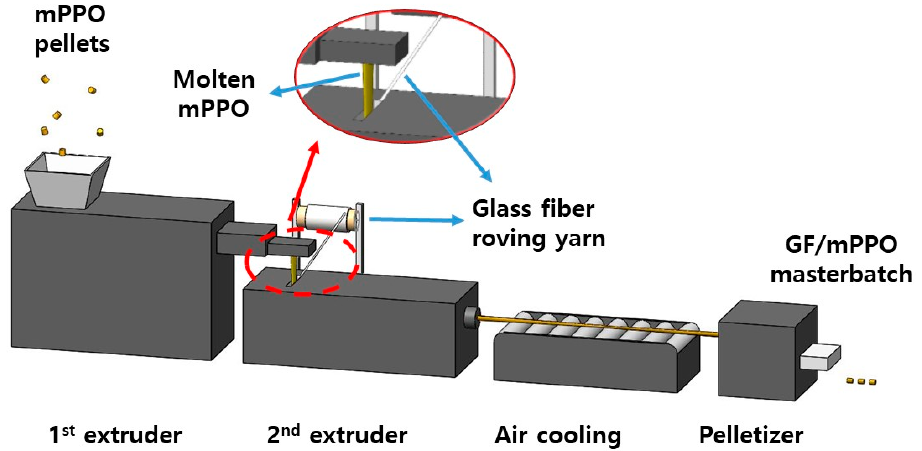
Figure 1. Scheme of extruder system to prepare the GF/mPPO